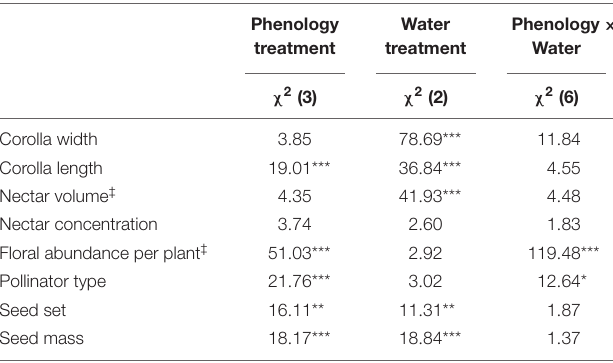
TABLE 1 | Results from analyses testing the effects of experimental variation in phenology and water treatments on floral traits, percent of visitors that were bumblebees (i.e., pollinator type), seed set, and seed